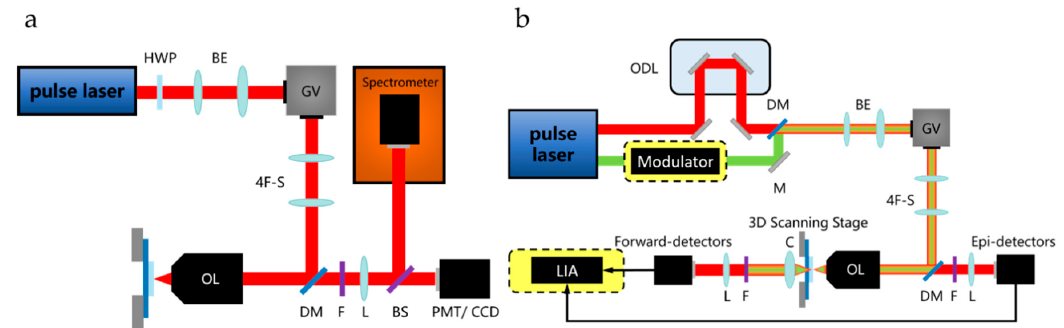
Figure 3. ( a ) Typical instrument of SHG / THG. ( b ) Typical instrument of CARS / SRS, the yellow dotted frame is the additional component needed for SRS system. HWP: half-wave plate; ODL: optical